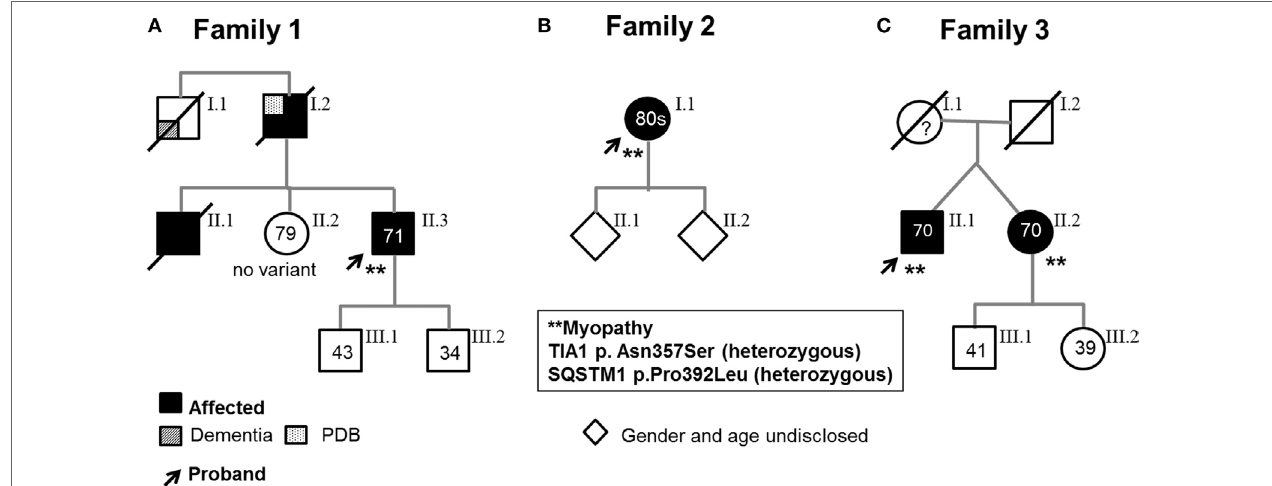
FigUre 1 | Pedigrees. Arrows indicate probands, who are heterozygous for both the SQSTM1 and TIA1 variants and have a muscle biopsy-proven myopathy. (a) Family 1. Proband 1’s asymptomatic sister (II.2) carries neither variant; the two asymptomatic sons carry neither variant nor the SQSTM1 variant. (B) . Family 2. One of Proband 2’s asymptomatic children harbors the TIA1 variant. (c) . Family 3. Affected dizygotic twin siblings carry both TIA1 and SQSTM1 variants (only the probands underwent muscle biopsy). The asymptomatic son and daughter carry neither variant nor only the TIA1 variant. As some of the probands’ children elected not to learn about their genetic status, carriers of specific variants are not indicated. (All living affected subjects were examined; the asymptomatic individuals were examined and had no weakness or were interviewed over the phone and denied weakness and symptoms suggestive of